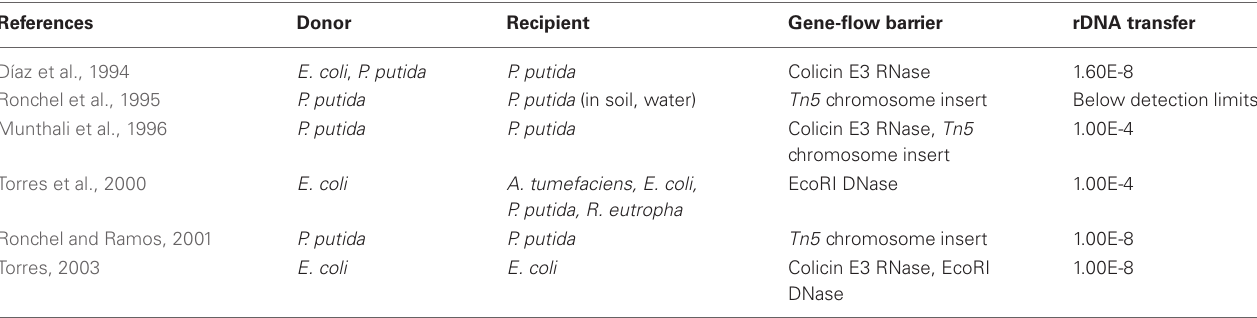
Table 2 | Efficacy of gene-flow